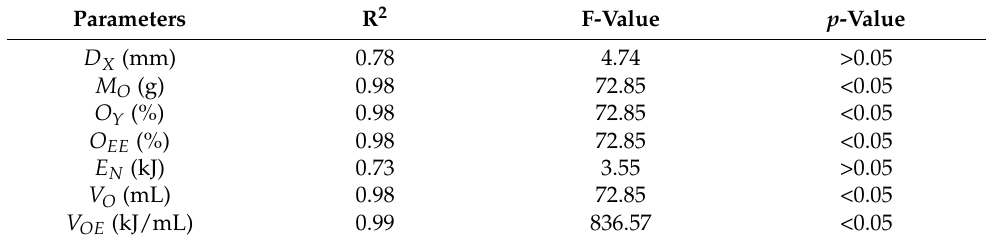
Table 3. ANOVA results of calculated parameters in relation to freezing